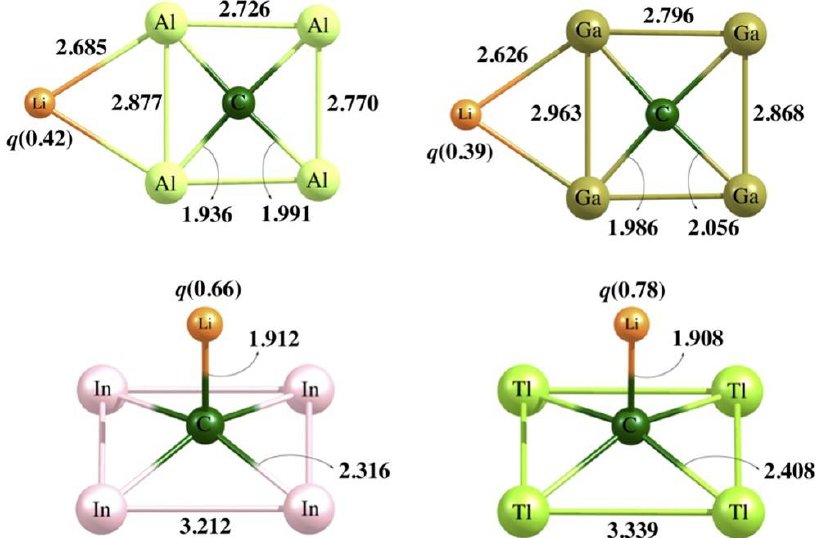
Figure 5. Lowest-energy structures of the CE 4 Li − clusters (E = Al, Ga, In, Tl), respectively, calculated at the B3LYP/def2-TZVP level. Bond lengths are given in Å. (Reprinted from ref. [57] with permission from Elsevier. Copyright © 2022 Elsevier B.V.).